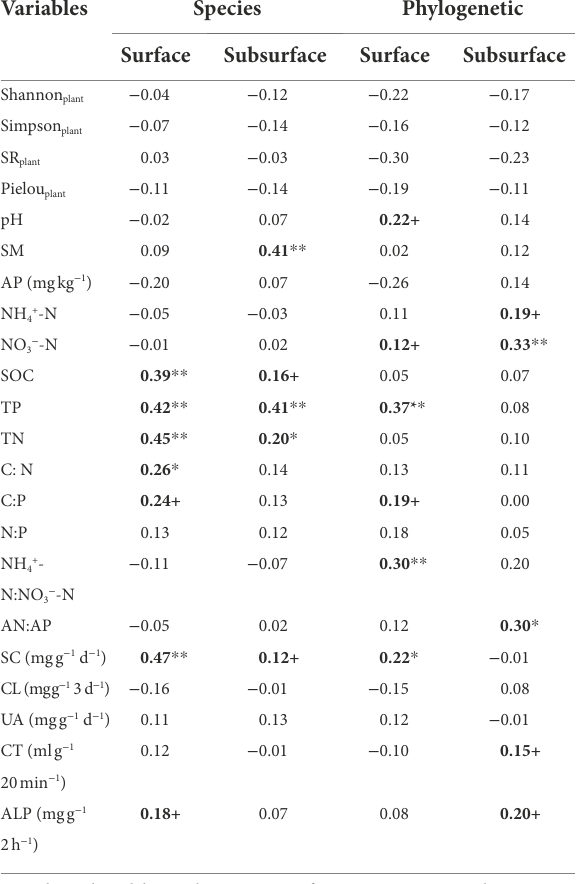
TABLE 1 Mantel test between soil bacterial species and phylogenetic community composition and soil and plant variables based on the Bray–Curtis and β MNTD dissimilarity